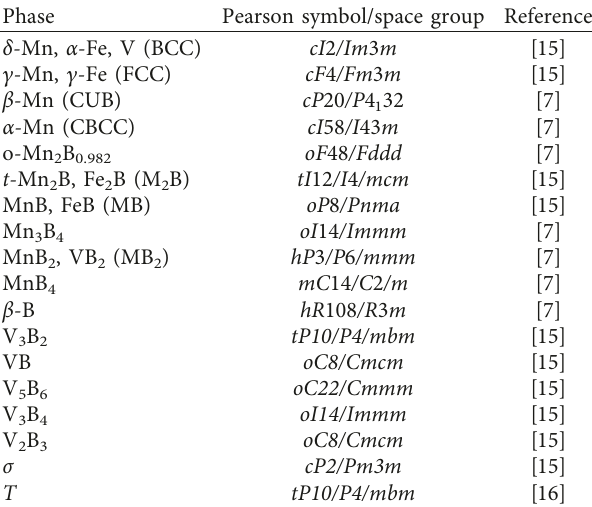
Table 3: Crystallographic data of the phases.